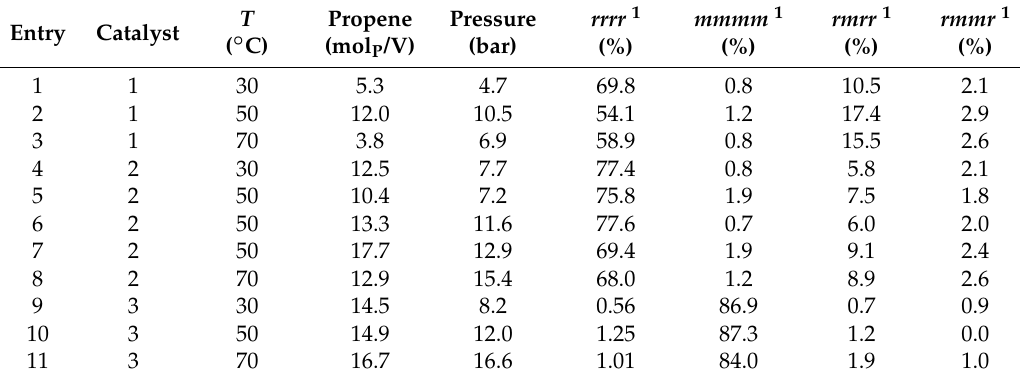
Figure 2. Methyl region of 13 C NMR spectra (108.58 MHz, C 2 D 2 Cl 4 , 103 ◦ C) of polyPP samples prepared at 50 ◦ C by: catalyst 1 ( a ); catalyst 2 at (Propene) = 13.9 M ( b ); and catalyst 3 ( c ). Table 2. Microstructure at Pentad Level of the Homopolymers Obtained.